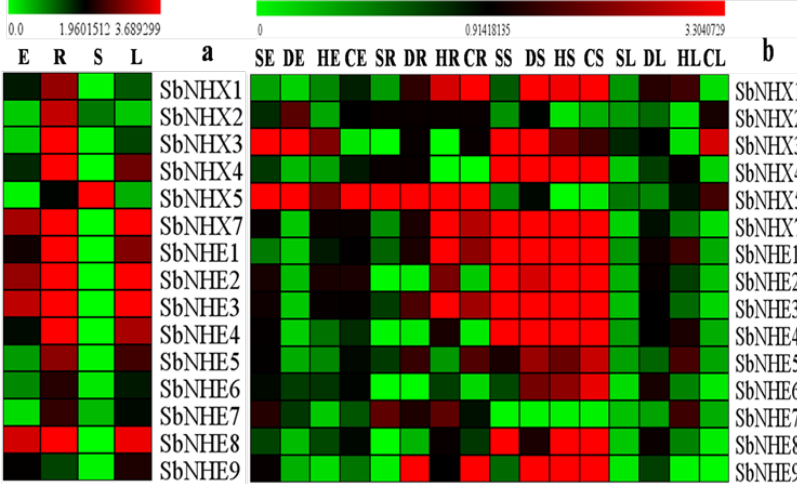
Figure 7. Relative expression analysis of SbNHX/NHE transporter genes in Sorghum . ( a ) Native expressions of the SbNHX/NHE transporters. ( b ) SbNHX/NHE transporters expressions to salt, drought, heat, and cold stresses. Relative expression of transporters is shown during different stress conditions in comparison to its corresponding controls. Values represent the expression levels obtained after normalizing against control tissues. All samples were analyzed in triplicate, in two independent experiments. Names on the horizontal axis indicate the tissues and the vertical axis represents various genes. E: embryo; R: root; S: stem; L: leaf; S: salt; D: drought; H: heat; C: cold. Each color represents the relative expression levels.